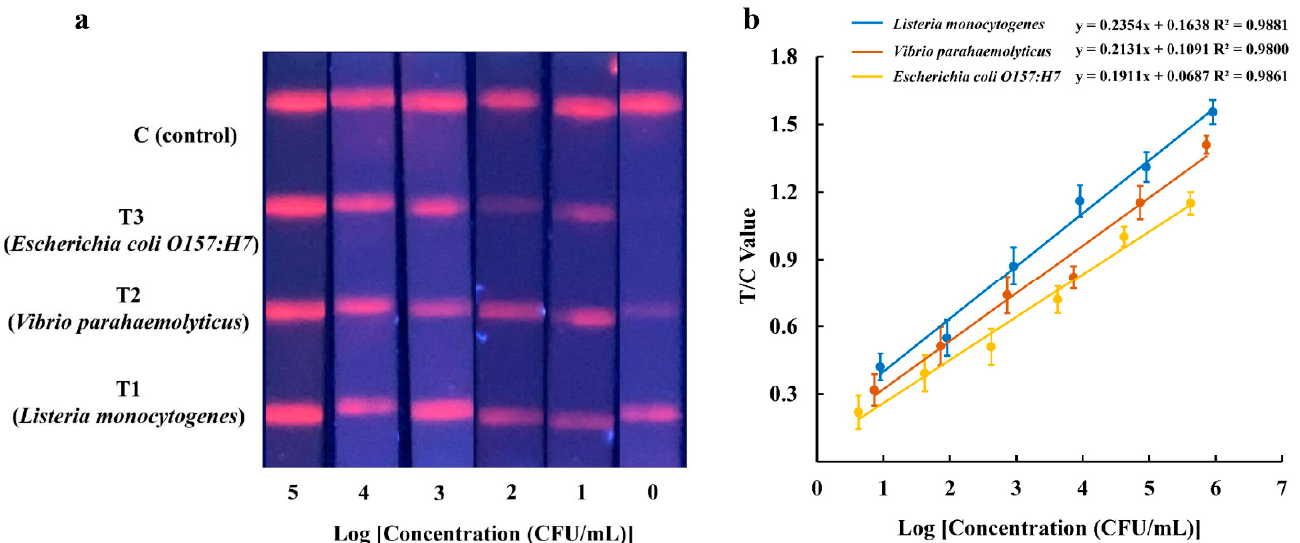
Figure 3. Reaction sensitivity of EuNP-based LFIA–RPA for Listeria monocytogenes , Vibrio parahaemolyticus , and Escherichia coli O157:H7 . The amplified products could be observed using a portable 365 nm UV lamp ( a ). Standard curves for Listeria monocytogenes , Vibrio parahaemolyticus , and Escherichia coli O157:H7 ( b ).